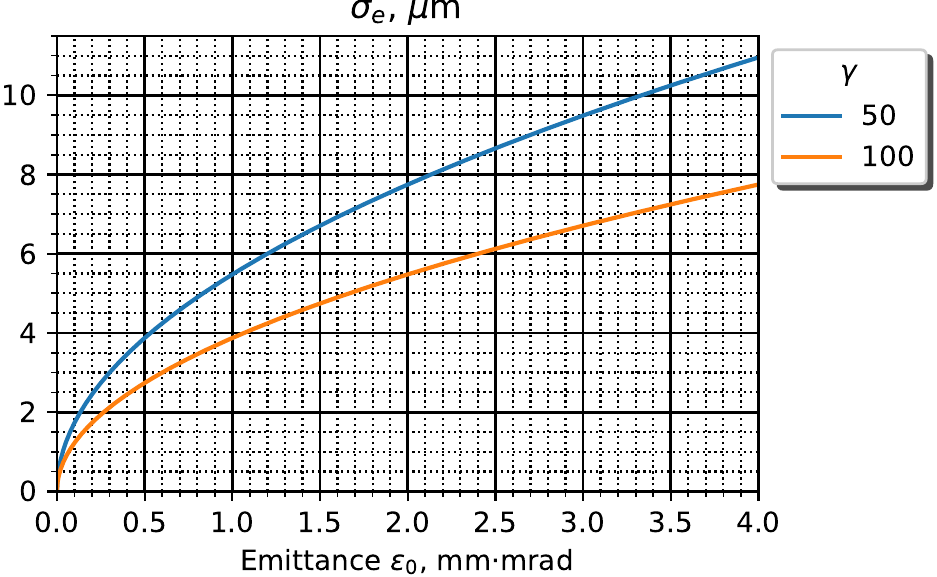
Figure 9. Transverse size of electron bunch in a focal spot σ e vs the normalized emittance ε 0 at relativistic factor values γ = 50 and